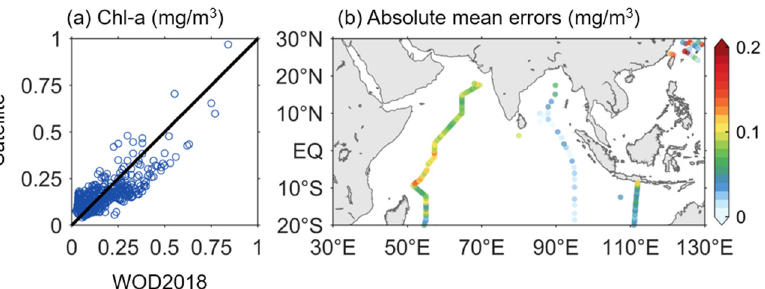
Figure 2. ( a ) Regression between WOD2018 in situ observed (x-axis) and satellite derived (y-axis) chlorophyll-a concentration. ( b ) Absolute mean errors between satellite derived SSC and in situ observed 10 m chlorophyll-a concentration in the Indian Ocean.